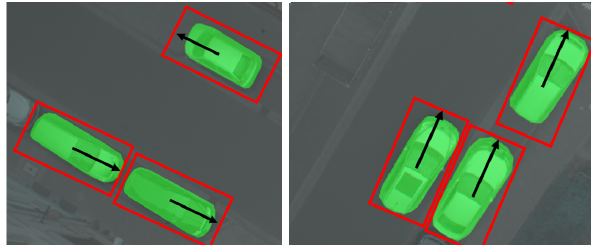
Figure 4. Qualitative results of V 360 on UAV 360 test images. Vehicle masks and oriented bounding boxes with heading are shown.